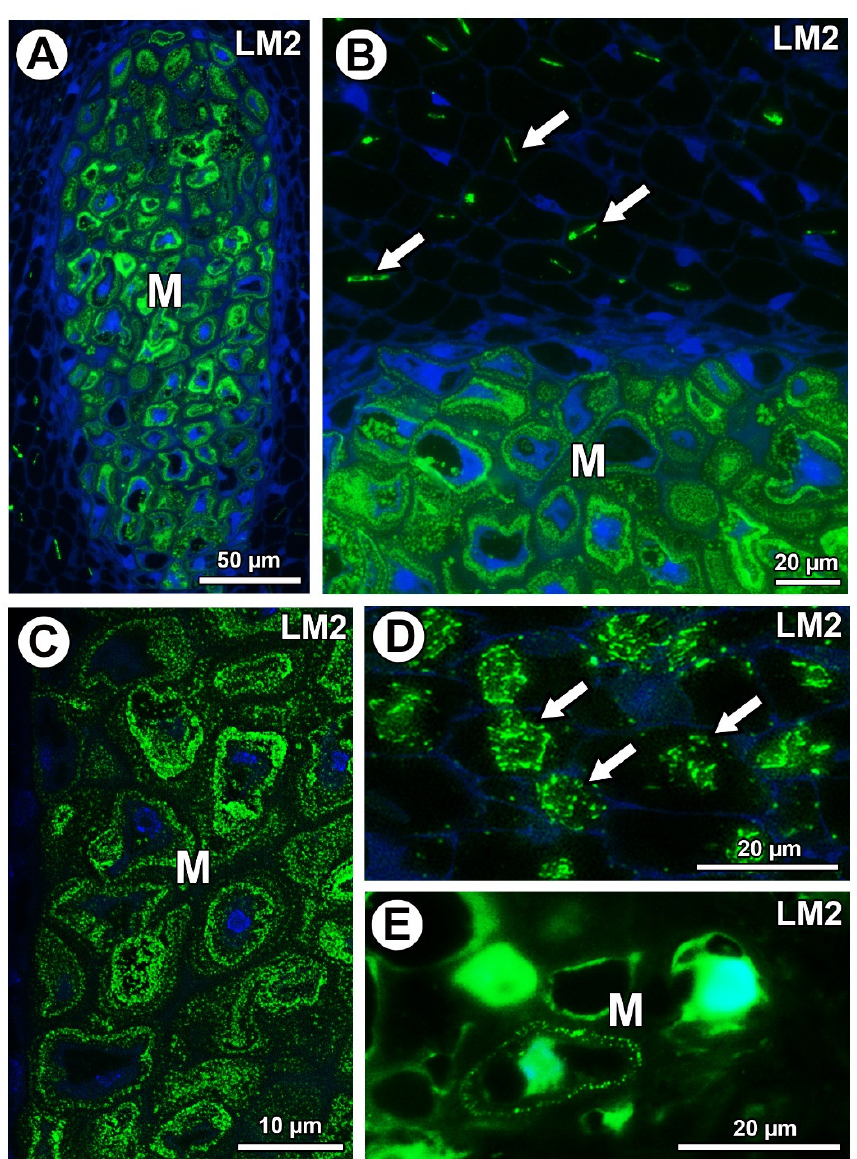
Figure 7. Detection of arabinogalactan proteins (labeled with LM2). ( A ) Section through the young seed of Taraxacum officinale ; AGPs occurred in mucilage cells (M). ( B ) AGP detection in mucilage cells (M) and association between AGPs and calcium oxalate crystals (arrows) in parenchyma cells in the young seed of T. officinale . ( C ) AGP detection in mucilage cells (M); note several distinct layers in the mucilage in the young seed of T. officinale . ( D ) Association between AGPs and calcium oxalate crystals (arrows) in parenchyma cells of Pilosella officinarum ovule. ( E ) AGP detection in mucilage cells (M) of P. officinarum ovule.